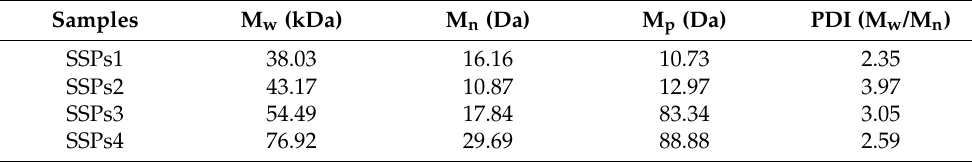
Table 2. Macromolecular of SSPs.